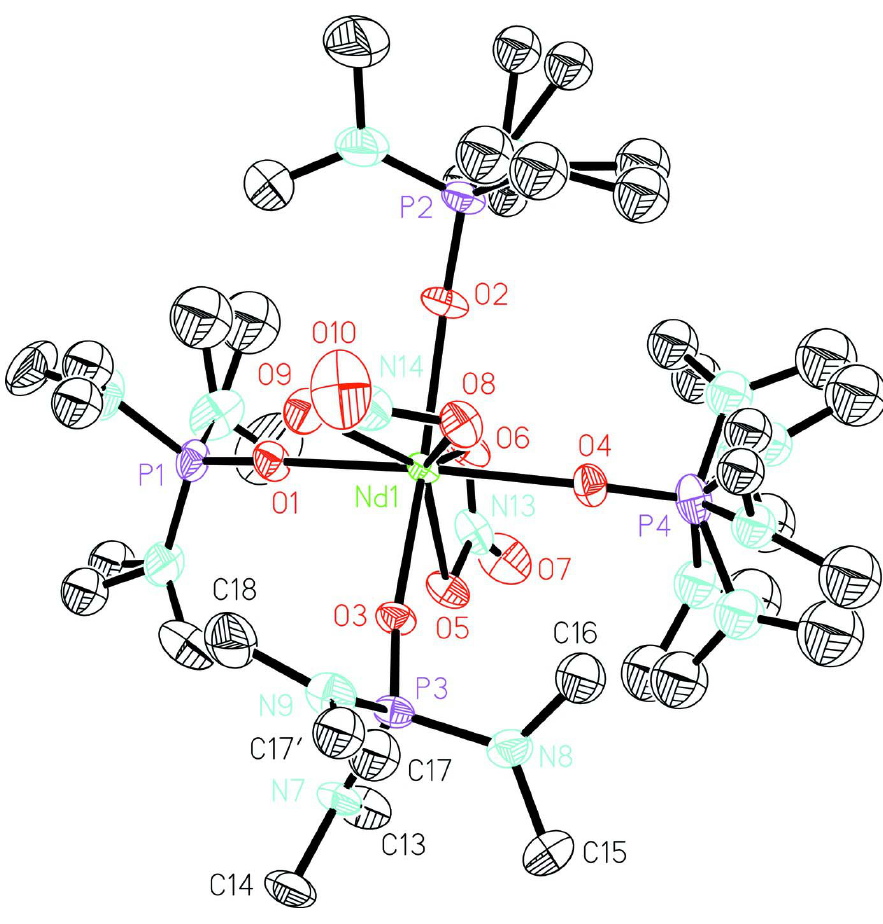
The molecular structure of the cation in the title compound, with atom labels and 30% probability displacement ellipsoids. All H atoms have been omitted for clarity.